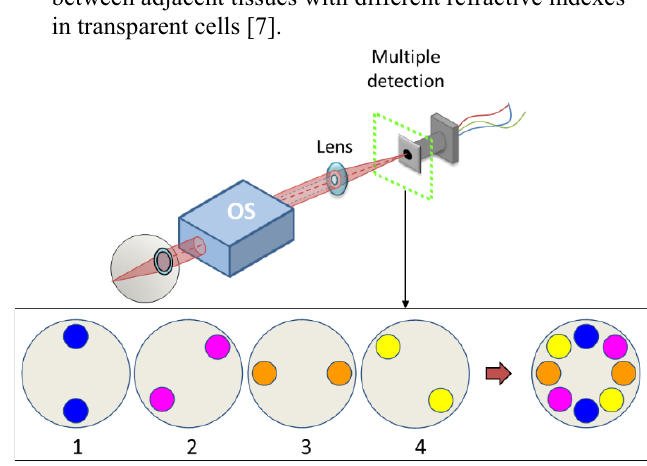
Fig. 1. Schematic drawing of the multi-offset detection configuration implemented on the Quinze-Vingt AOSLO. An arrow indicates the place of the detection fiber bundle which is placed on a rotation stage and rotated to four positions to sequentially obtain the 8 positions multi-offset pattern. OS: Optical system.